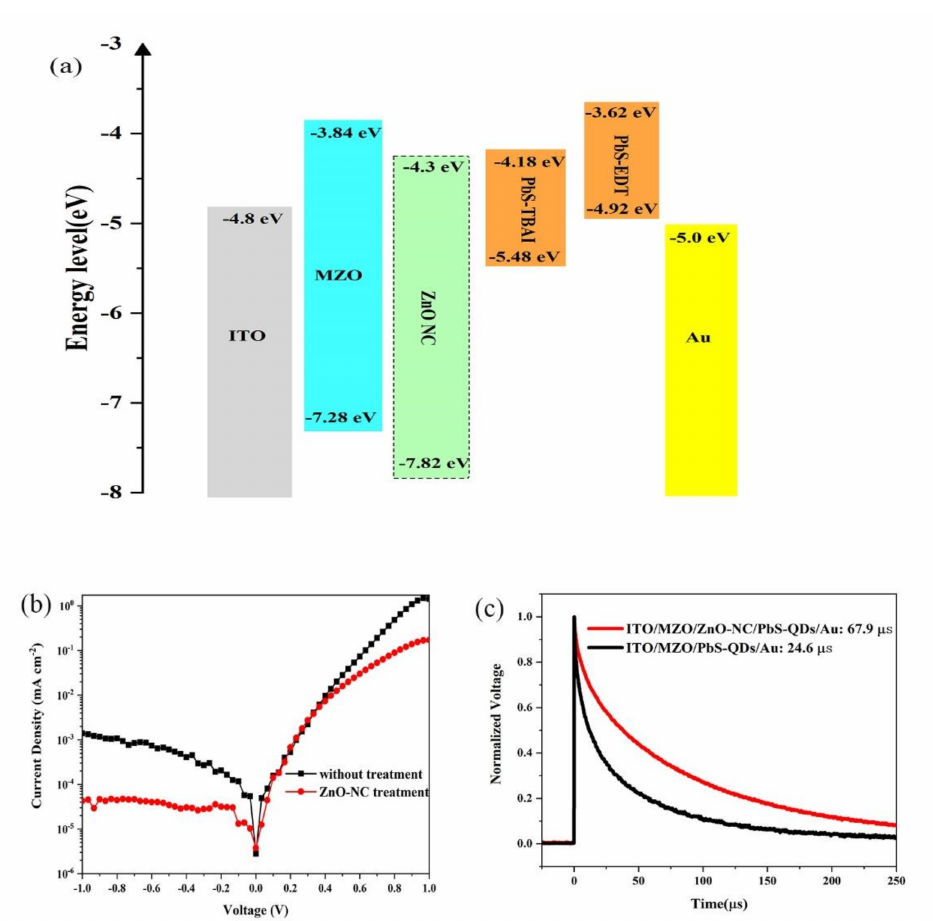
Figure 6. ( a ) The band alignment of PbS CQD solar cells with inverted structure of ITO/Mg- doped ZnO (MZO)/ZnO NC/PbS-TBAI/PbS-EDT/Au. ( b ) Dark J-V curves of PbS CQD solar cells with/without ZnO NC layer. ( c ) Transient photovoltage (TPV) measurements of PbS solar cells with/without ZnO NC